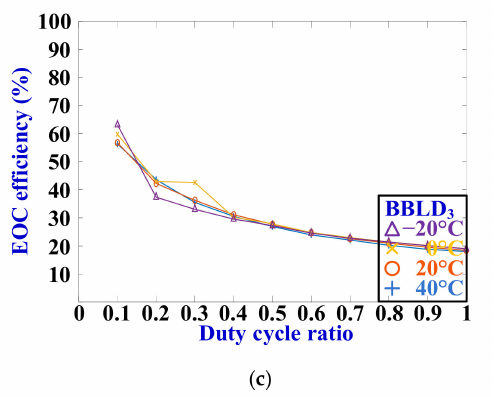
Figure 13. EOC e ffi ciencies using electrical power mean-value calculation ( f s = 400 Hz). ( a ) BBLD 1 . ( b ) BBLD 2 . ( c ) BBLD 3 .